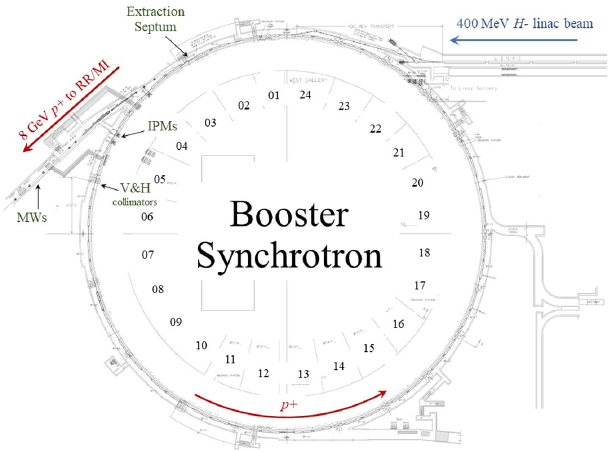
FIG. 1. Schematics of the Fermilab Booster synchrotron. Sectors, each consisting of four combined function magnets, are numerated 1 to 24. Indicated are locations of the ionization profile monitors (IPMs), MultiWires (MWs) beam profile mon- itors in the 8 GeV proton transport line and the 400 MeV H − beam injection line.